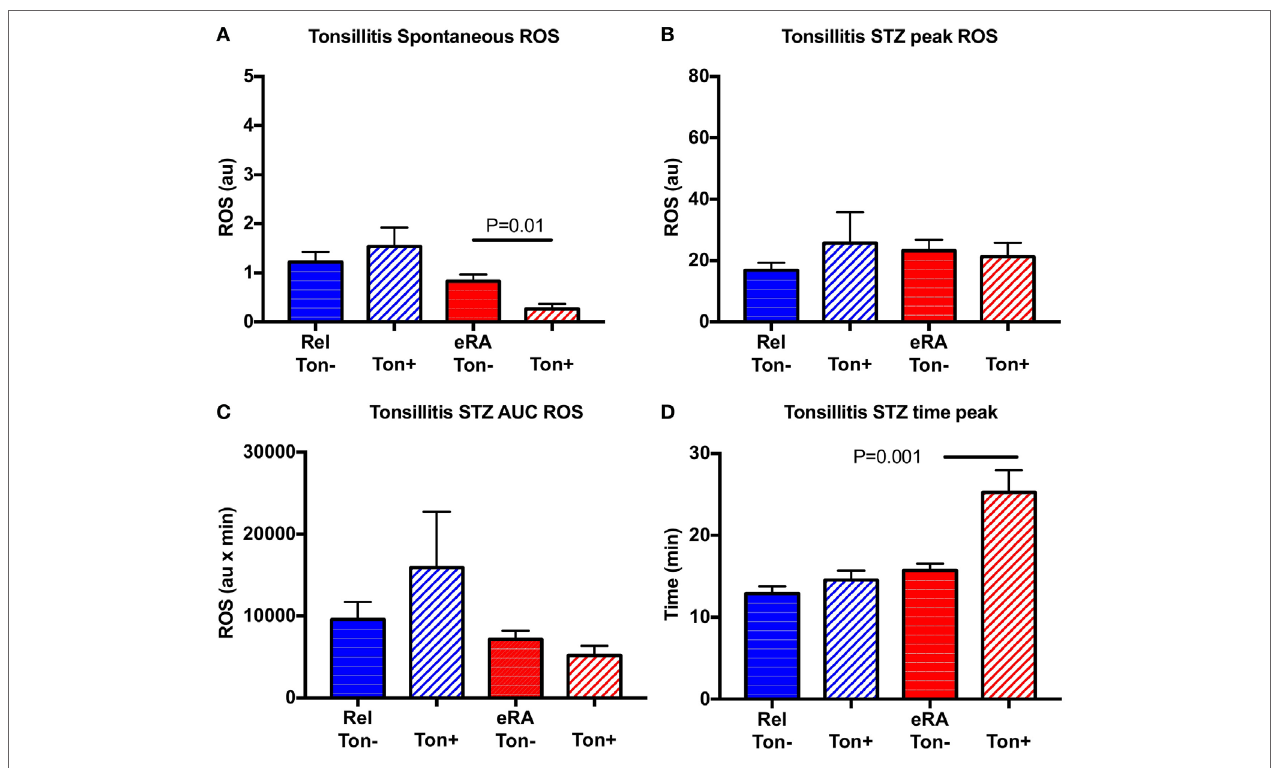
FigUre 6 | Impact of a history of chronic tonsillitis exacerbation in the year preceding sample collection in granulocyte reactive oxygen species (ROS) production: spontaneous (a) , after serum treated zymozan (STZ) stimulation at peak (b) , area under the curve (AUC) (c) , and time to reach peak ROS production (D) . Healthy controls (Cont), rheumatoid arthritis (RA) first-degree relatives (Rel), and untreated RA patients at onset (early RA). Statistics are indicated when P ≤